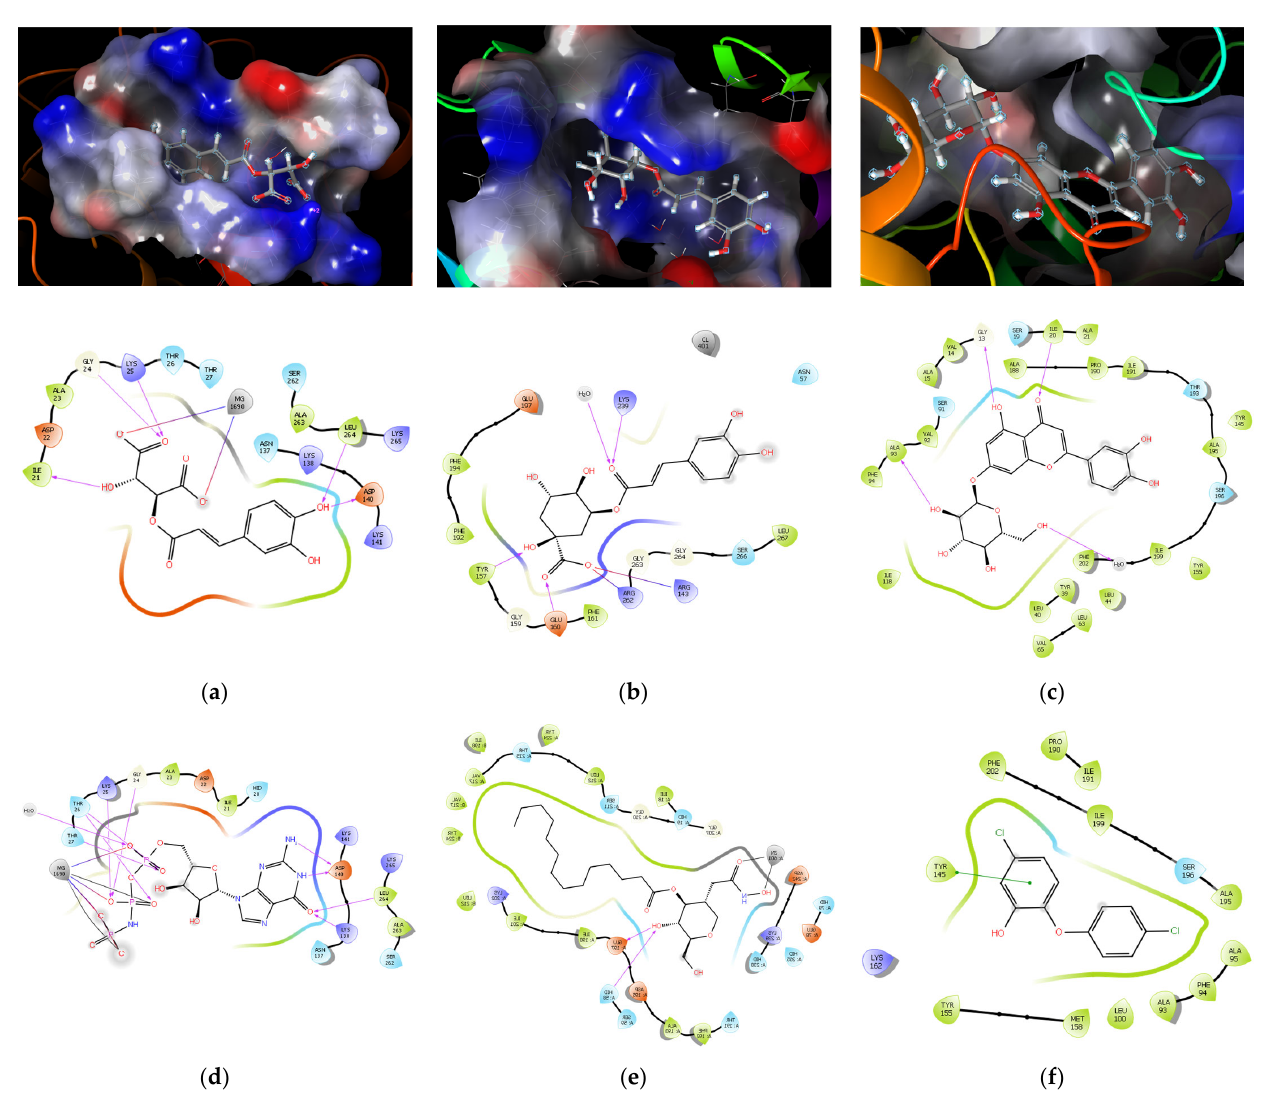
Figure 6. Binding conformations after molecular docking for the most potent targets and ligands: ( a ) Rosmarinic acid, the diagram shows the formation of a salt bridge with a magnesium ion, as well as the interaction with the electrostatic surface of the binding site with 2BV3; ( b ) chlorogenic acid, hydrogen bond diagram and electrostatic binding site surface with 2GO4; ( c ) luteolin-7-O-glycoside, hydrogen bond diagram and electrostatic surface of the binding site with 2PD4; ( d ) ligand interaction diagram for 2BV3 with natural ligand; ( e ) ligand interaction diagram for 2GO4 with natural ligand; and ( f ) ligand interaction diagram for 2PD4 with natural ligand. The antioxidant and antimicrobial properties of biologically active substances in T. Table 5. Antimicrobial activity (diameter of the growth inhibition zone of test microorganisms, mm) of BASs from T. vulgare